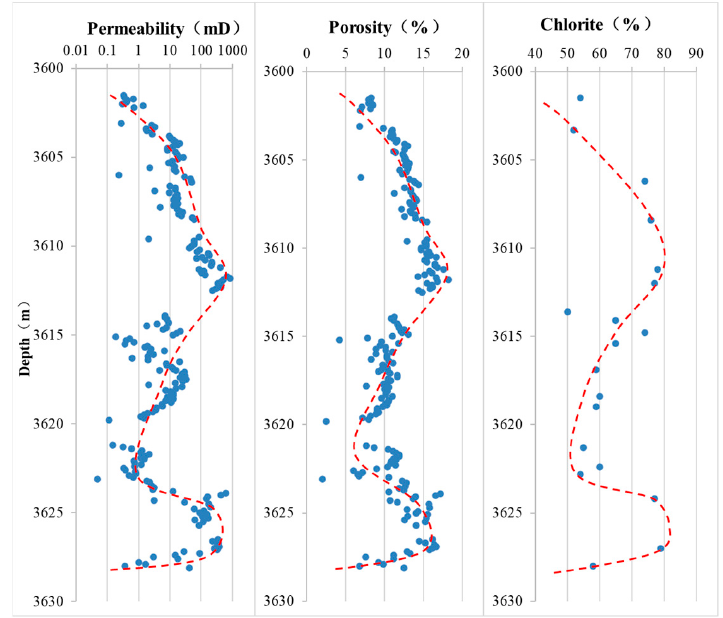
Figure 7. Correlation between chlorite content and petrophysical properties in the H3 coring section of Well X-2.